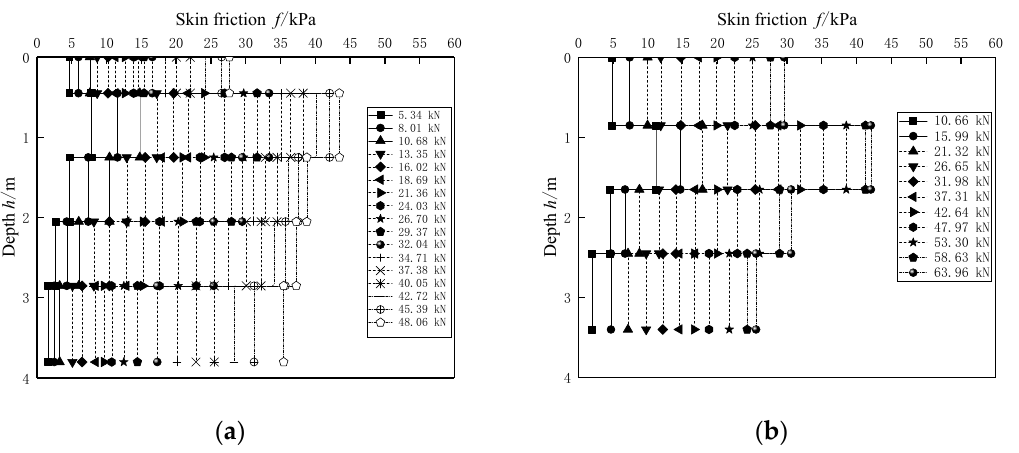
Figure 7. Distribution curve of the skin friction: ( a ) the pile-end soilless compressive pile and ( b ) the conventional compressive pile.